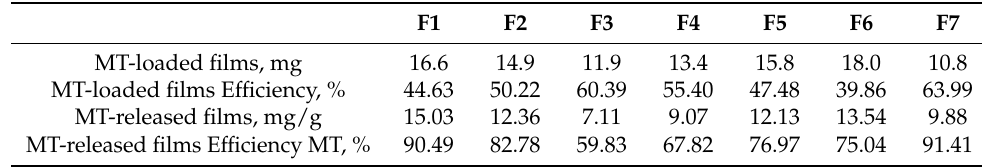
Table 3. MT loaded and released film profiles.